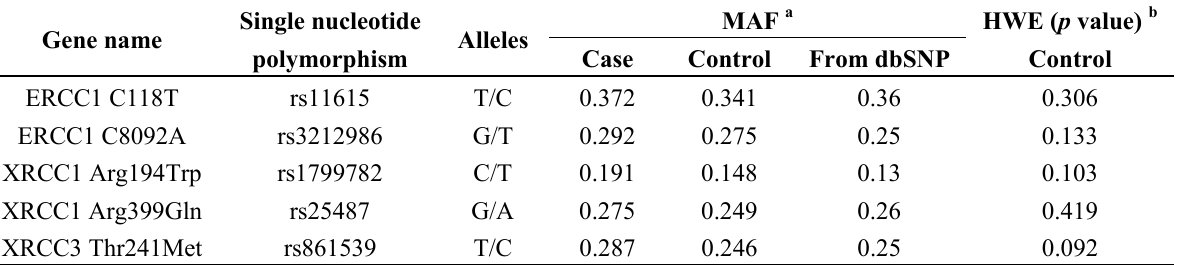
Table 2. Genotype characteristics of the five single nucleotide polymorphisms (SNPs).